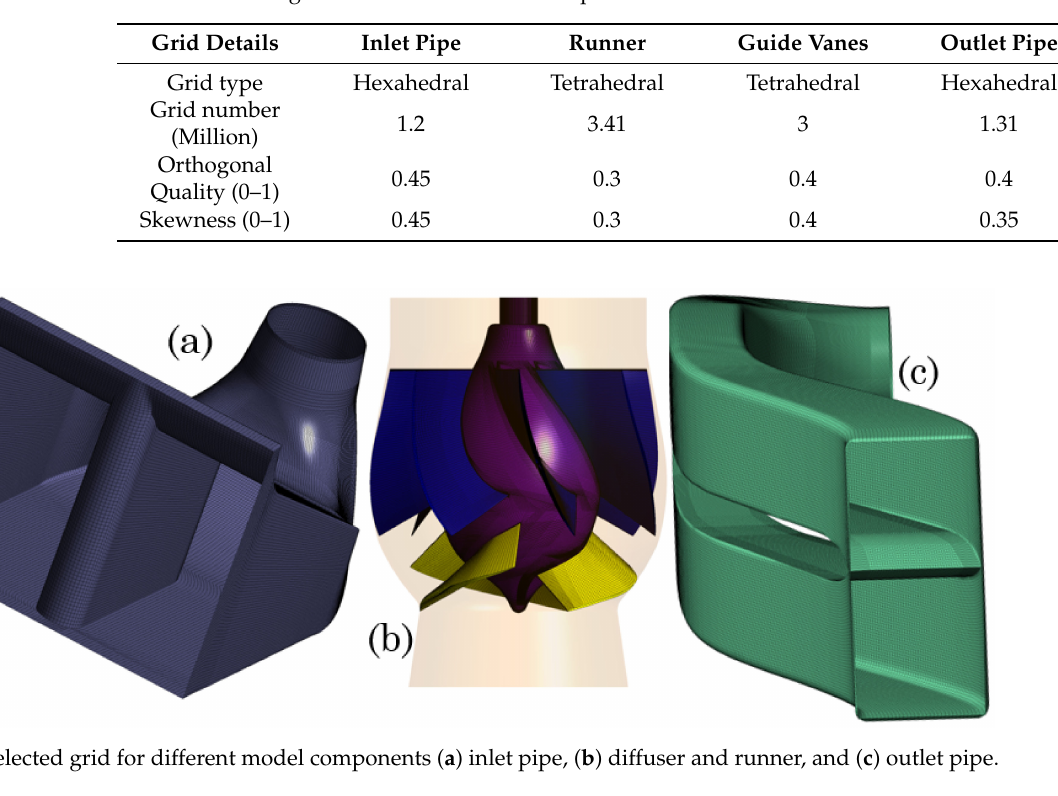
Figure 5. Grid independence test. Table 2. Selected grid details for each PAT component.